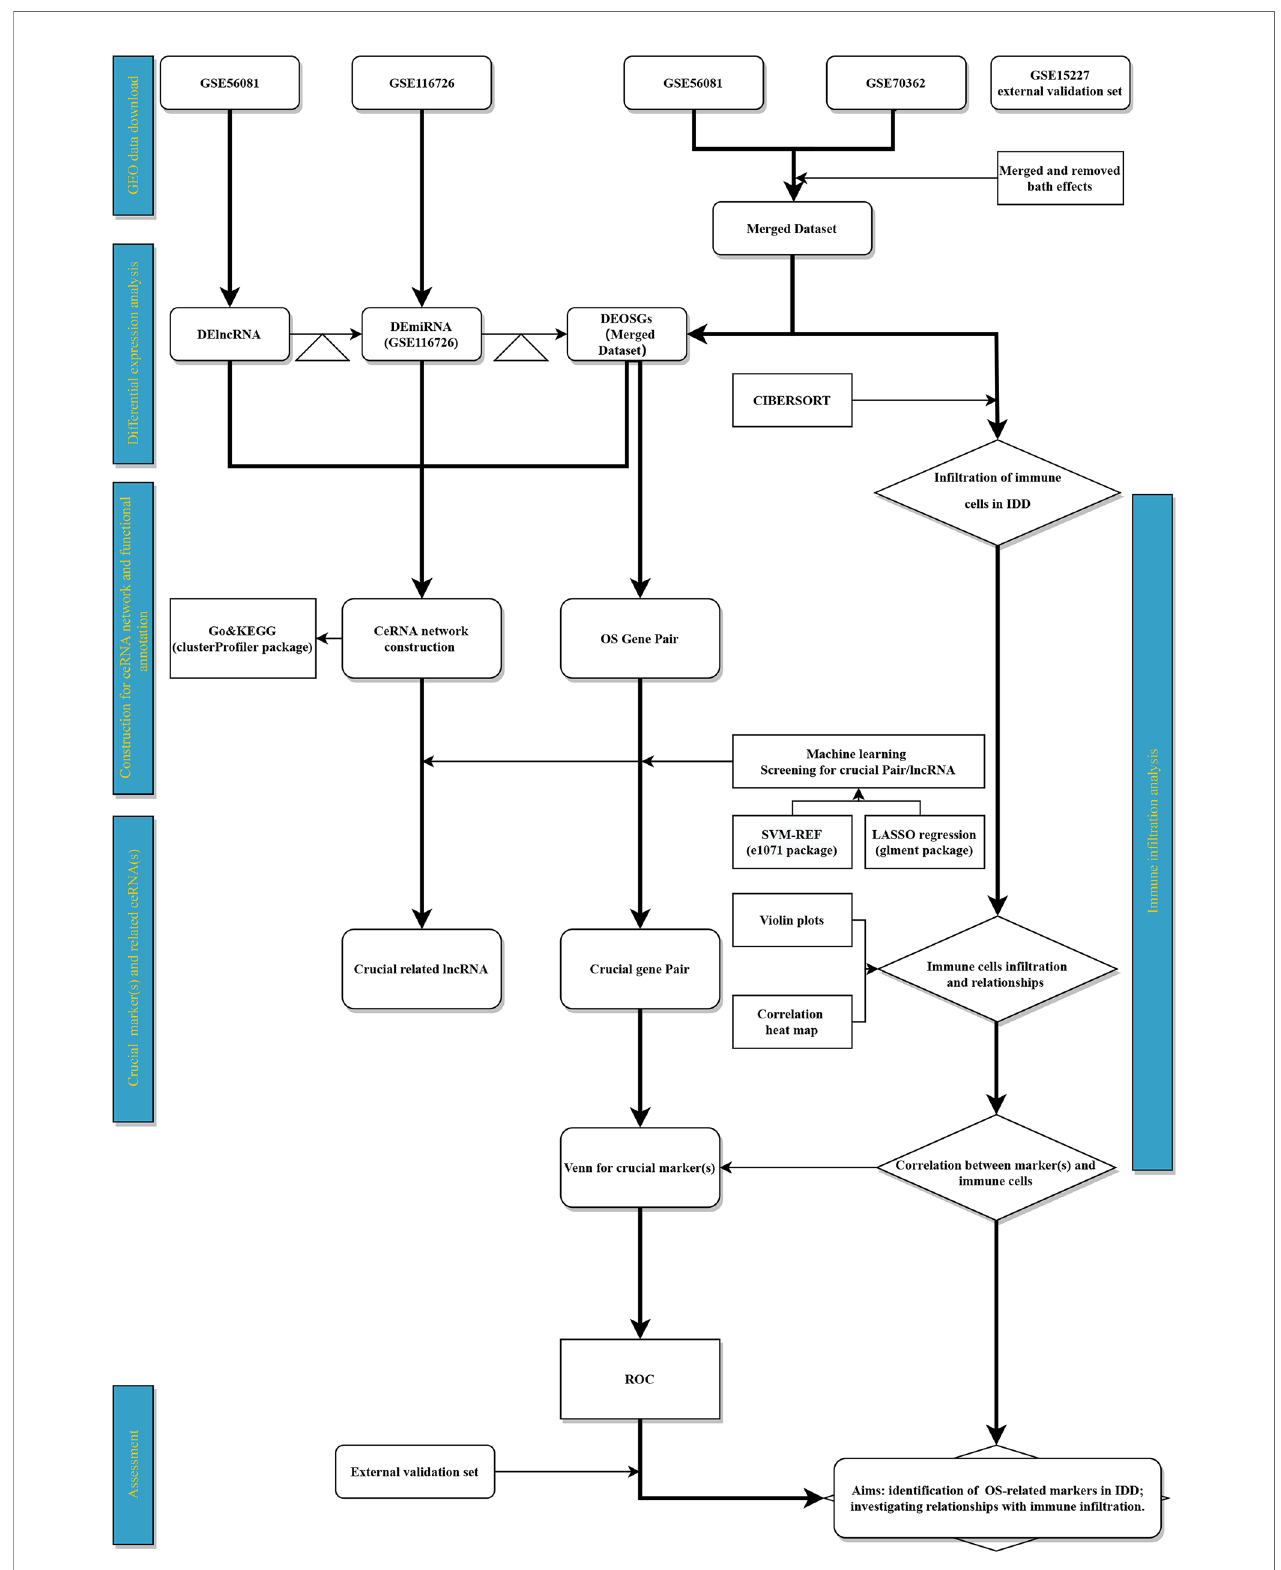
FIGURE 1 | Flowchart. Triangle represents target ‐ gene prediction ( fi rst triangle, lncRNA target prediction; second triangle, miRNA target prediction).